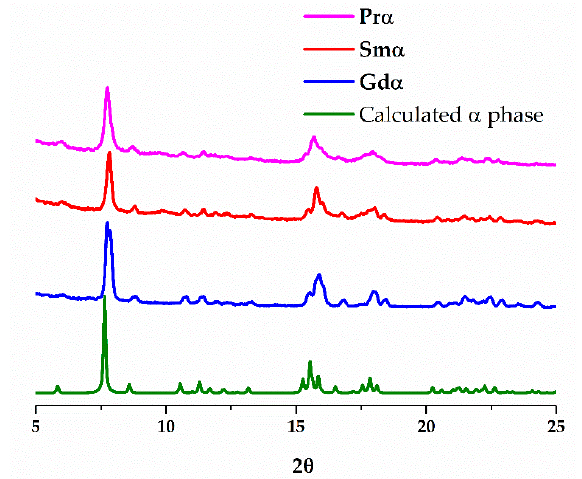
Figure 3. Theoretical powder X-ray diffractogram for the 2D α structure simulated from the single crystal data of Pr α (green). Experimental powder X-ray diffraction pattern obtained for the bulk sample prepared by direct mixing of a 15 mL water solution of 0.095 mmol (0.06 g) of K 3 [Ru 2 (CO 3 ) 4 ]·4H 2 O into a solution of 0.11 mmol of the corresponding Ln(NO 3 ) 3 ·6H 2 O in 15 mL of DMSO (Pink: Ln = Pr. Red: Ln = Sm. Blue: Ln = Gd).